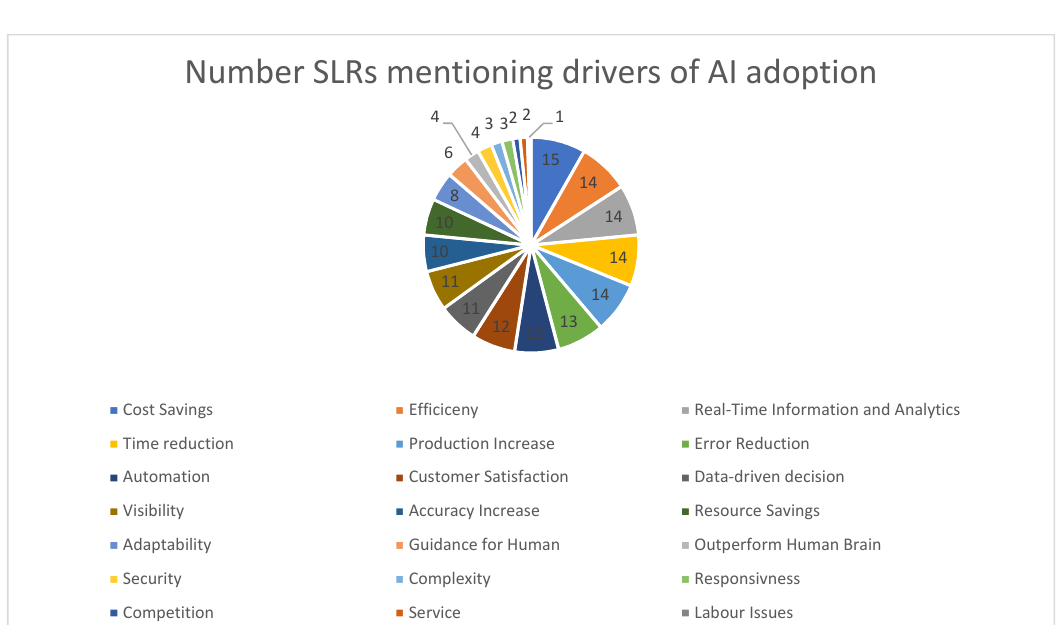
Figure 6. Barriers to AI adoption in SCM.